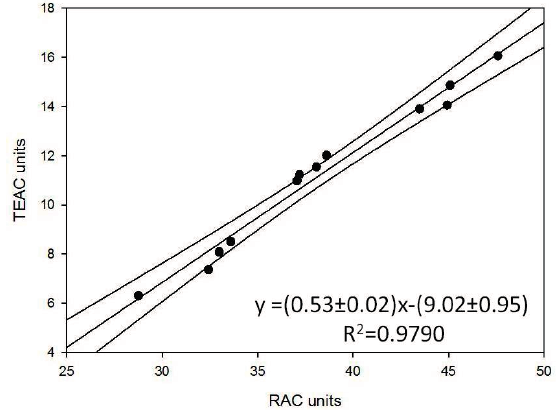
Figure 5. Correlation curve between the ORAC and SOD biosensor methods.